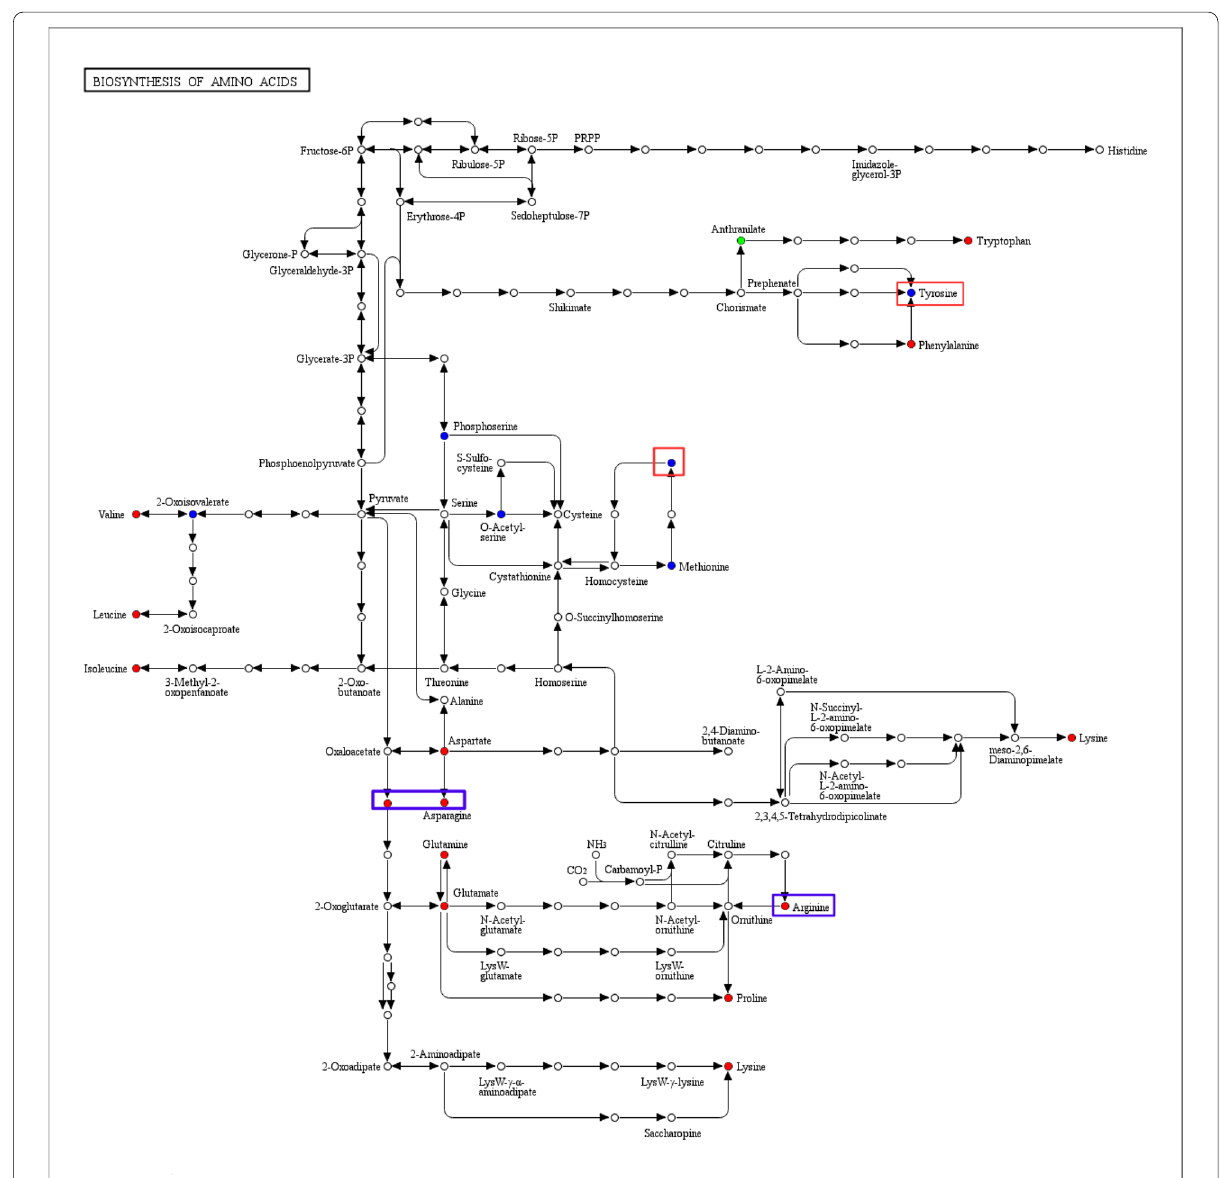
Fig. 9 Synthesis pathway of amino acids. Red indicates a significant increase in metabolite content in the experimental group, blue represents the metabolite was detected but no significant change, and green indicates a significant decrease in metabolite content in the experimental group. The red boxes represent that the metabolite content is significantly up-regulated in HN65, and the blue boxes represent that the metabolite is detected in HN65 but have no significant